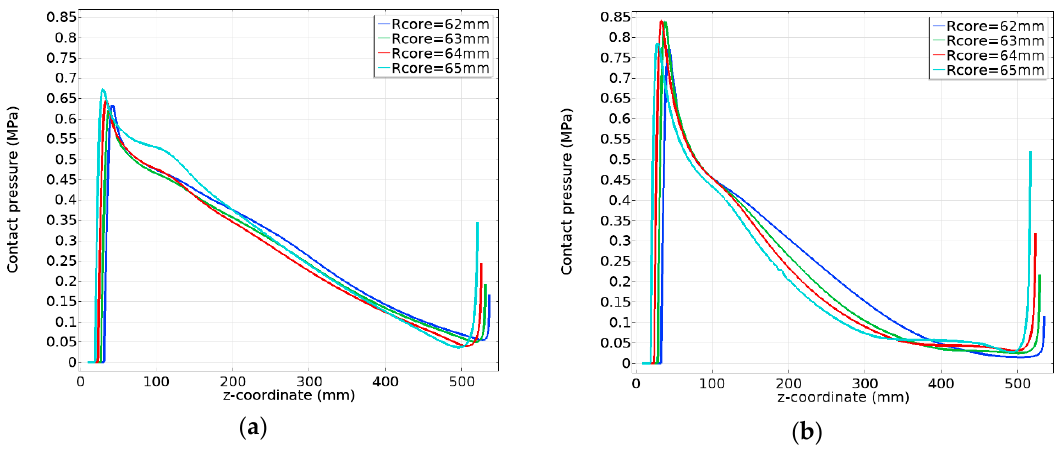
Figure 15. Contact pressure distributions between the optimized stress cone and the cable core are presented in ( a ) and ( b ) considering friction coefficients of 0.2 and 0.4, respectively.